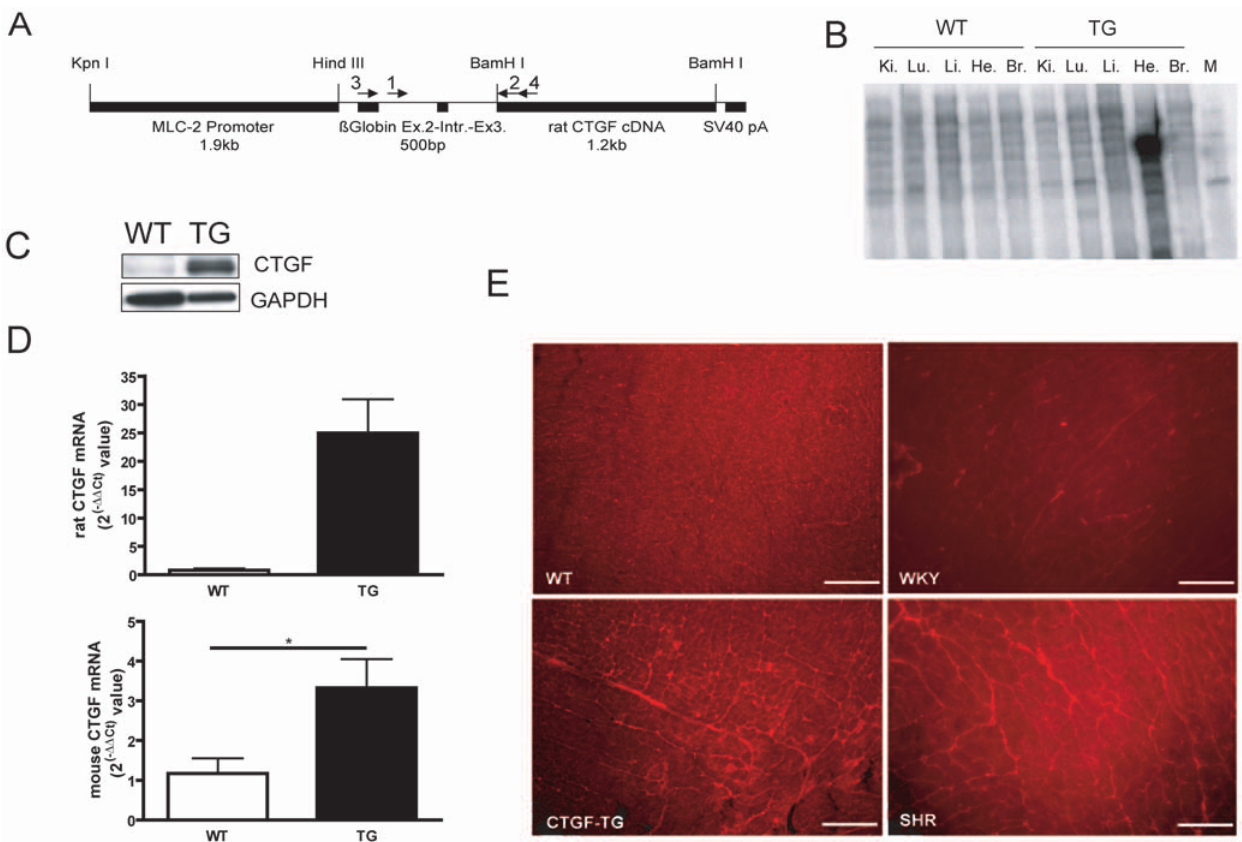
Figure 1. Construction of cardiomyocyte-specific CTGF-TG mice. (A) Schematic structure of the transgene. 1 and 2 indicate primers used for genotyping and 3 and 4 show primers used to generate the probe for CTGF ribonuclease protection assay. MLC-2 (myosin light chain-2) promoter; rabbit b -globin exon 2 and 3 for enhanced expression of the transgene; SV40 pA, polyadenylation signal from Simian virus 40. (B) Expression of CTGF mRNA in hearts (He) and other organs (kidney, lung, liver, brain) of transgenic mice shown by ribonuclease protection assay. (C) Western Blot analyses of CTGF protein overexpression in CTGF-TG mouse hearts. GAPDH protein expression was used as loading control. (D) Quantification of the transgenic and endogenous CTGF mRNA expression by TaqMan PCR. (WT n=4, TG n=4; *, P , 0.05 (E) Histological staining of CTGF in WT and CTGF- TG mice as well as in Wistar-Kyoto rats (WKY) as control for spontaneously hypertensive rat (SHR). Scale bars designate a length of 100 m m.